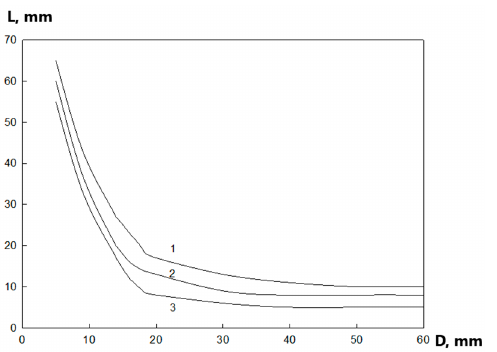
Figure 11. Critical dimensions of twigs providing ignition: 𝐻 = 5 mm, 1 – 𝑣 = 1.5 m/s, 2 – 𝑣 = 2.5 m/s, 3 – 𝑣 = 3.5 m/s.